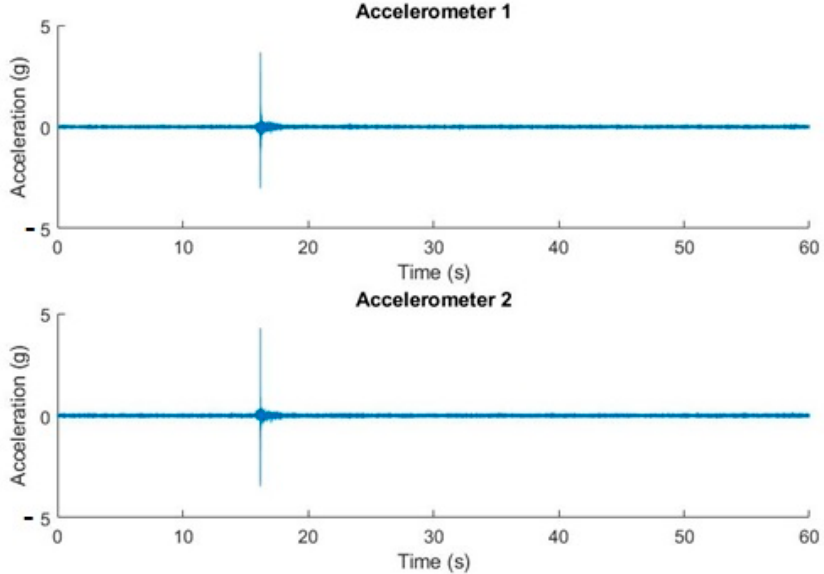
Figure 12. Waveform of channels 1 and 2. Straight ascension movement with vibration peak.